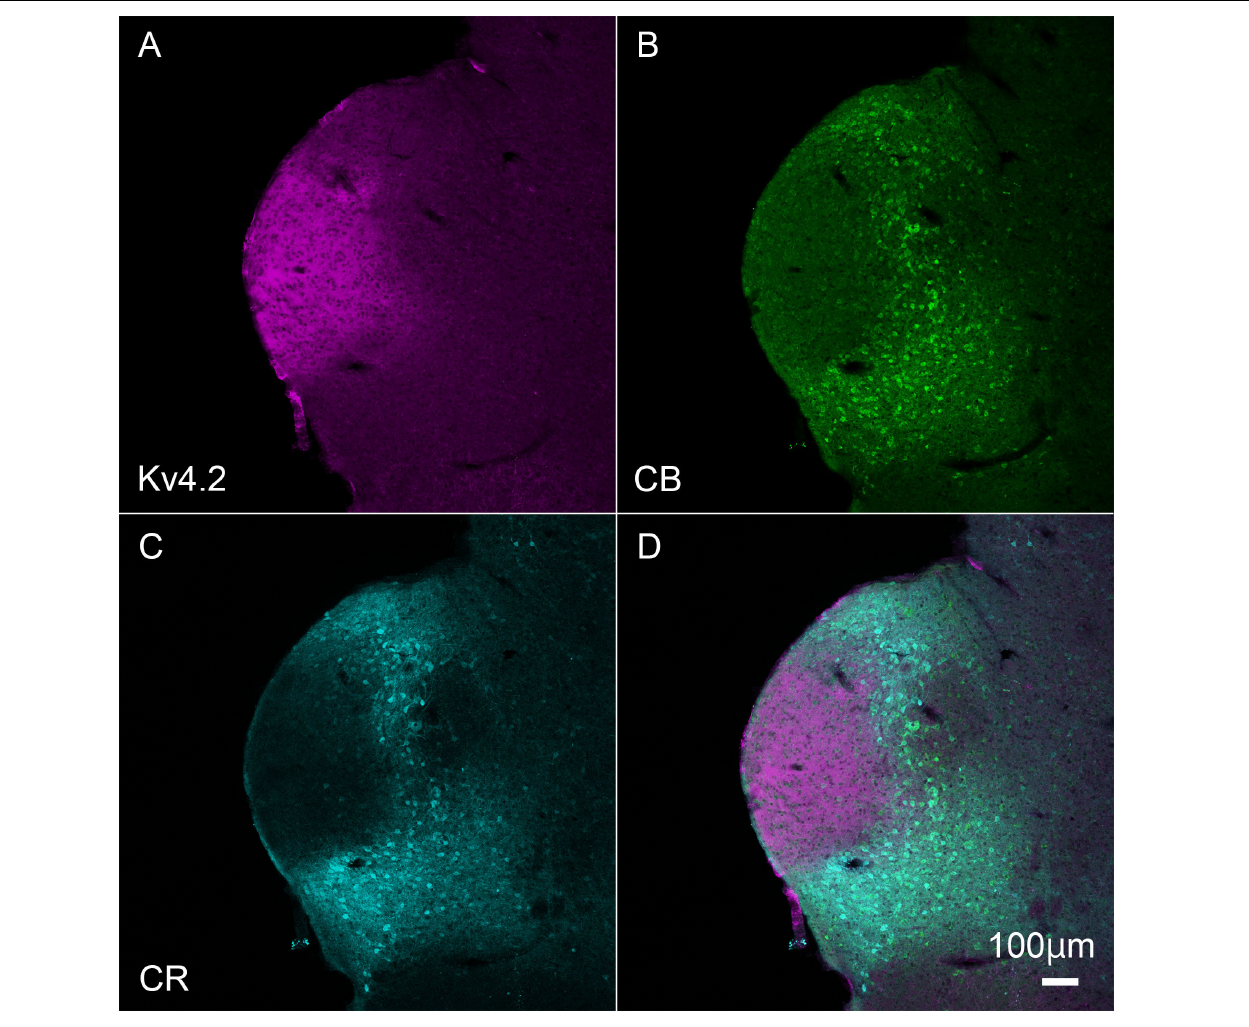
FIGURE 3 | Kv4.2 protein expression is mainly observed in the ventral MGB examined by immunohistochemistry. (A–D) Triple fluorescence labeling for voltage-dependent potassium channel 4.2 (Kv4.2, magenta: A ), calbindin (CB, Green: B ), calretinin (CR, cyan: C ), and merged (D) images in the adult mouse brainstem coronal section including MGV. Scale bar: 100 µ